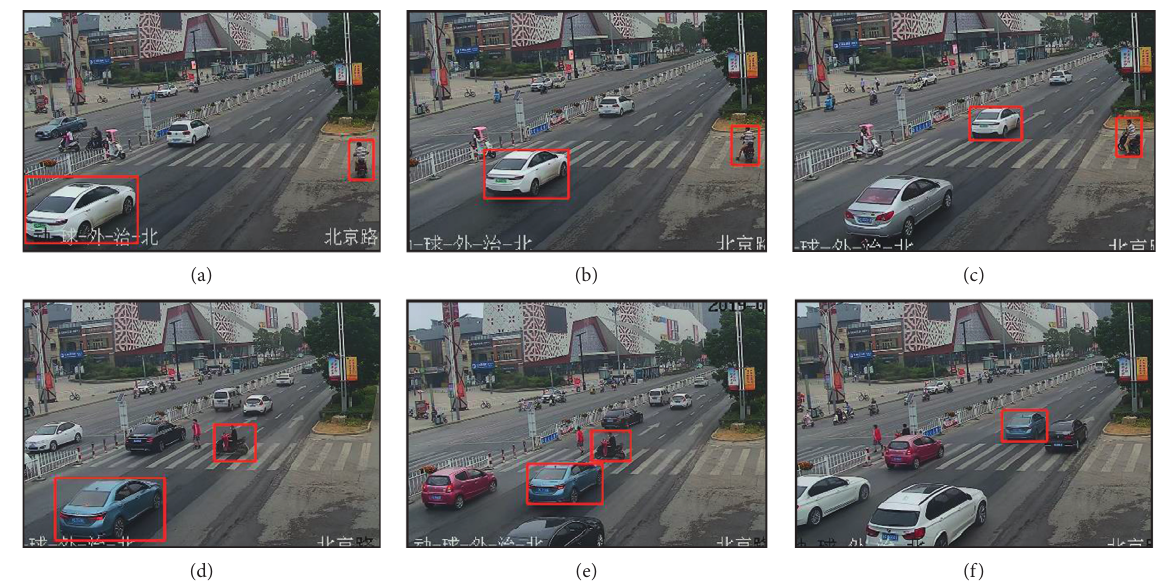
Figure 1: The process of vehicles passing bicycles at crosswalks in real traffic